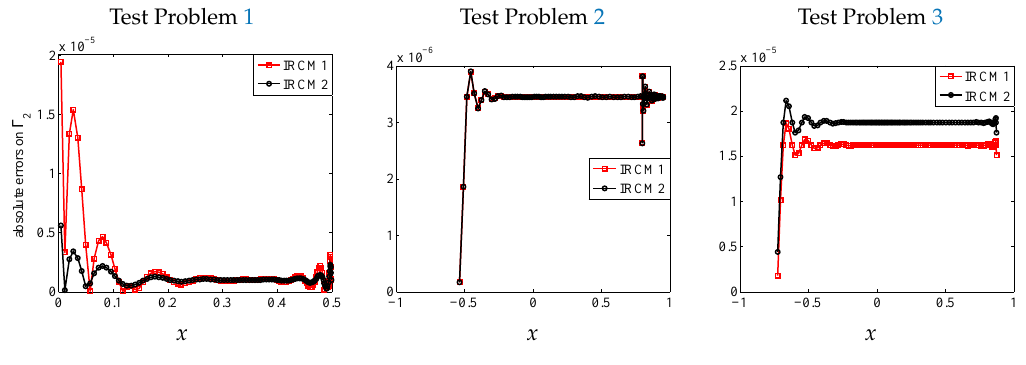
Figure 11. Test Problems 1–3, absolute errors | u ( ˆ v ) − u ( ˆ v ) | using the methods IRCM1 and IRCM2 versus x on boundary parts Γ 2 , (cid:101) = 80, and γ = 1.